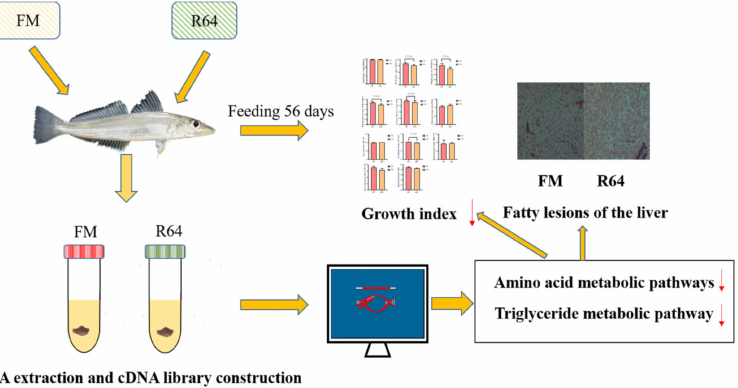
Figure 1. The experimental protocol and result of this study. The red arrow indicates